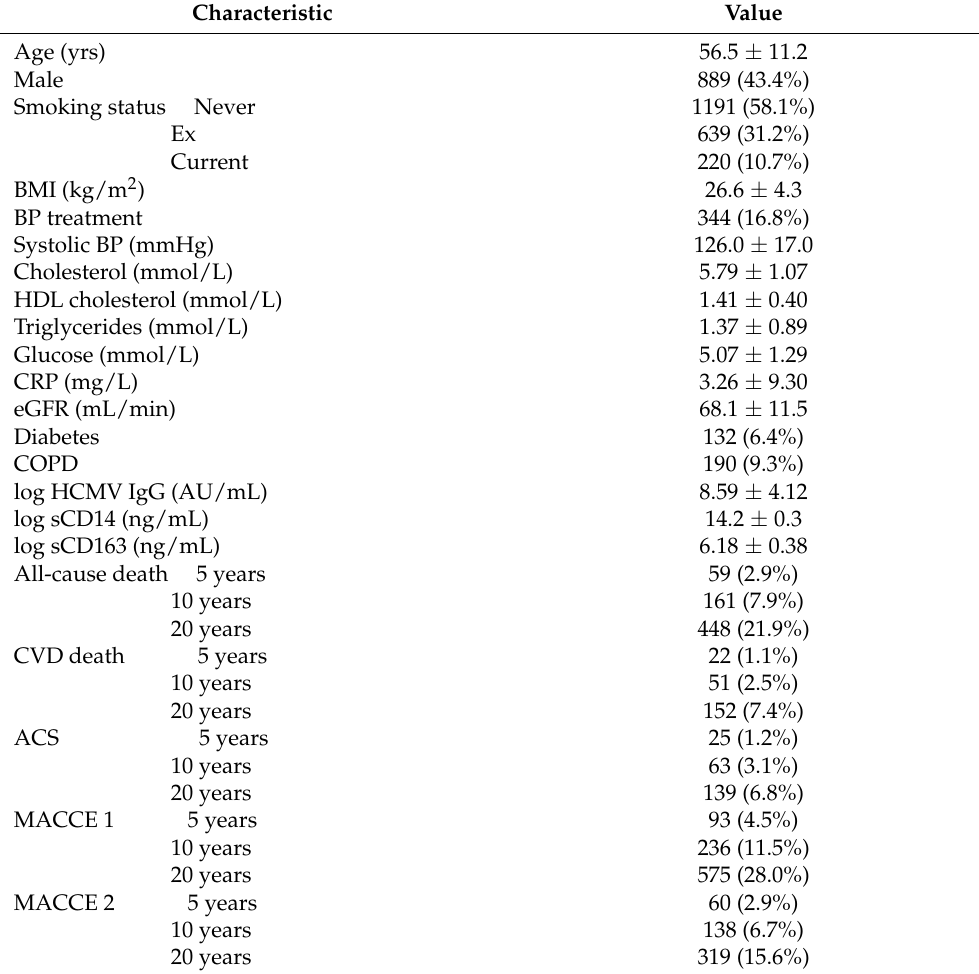
Table 1. Baseline characteristics of Busselton Health Study participants (n =